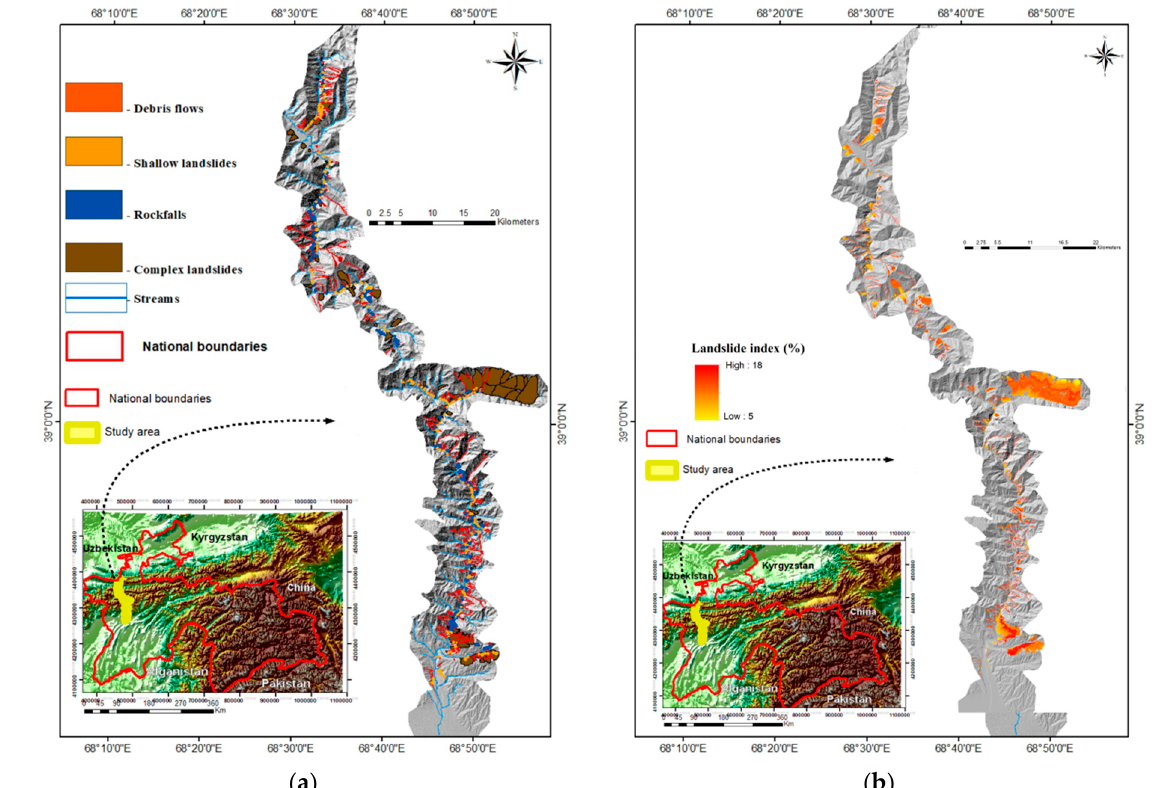
Figure 7. Landslide inventory map of the study area ( a ) , landslide index (%, landslide area/total area × 100 ( b ).